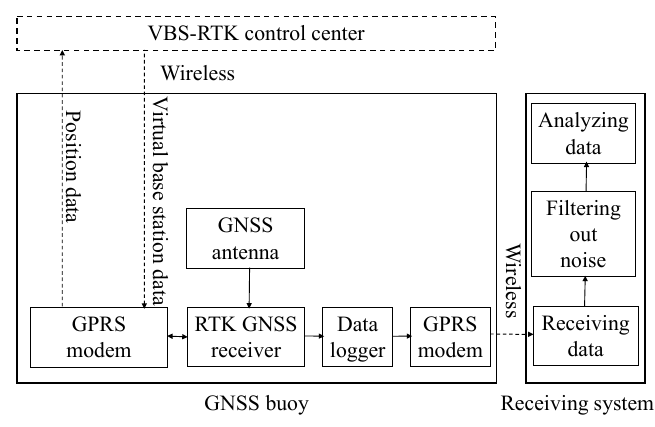
Figure 1. Working principle of a GNSS buoy for monitoring the water surface elevation.